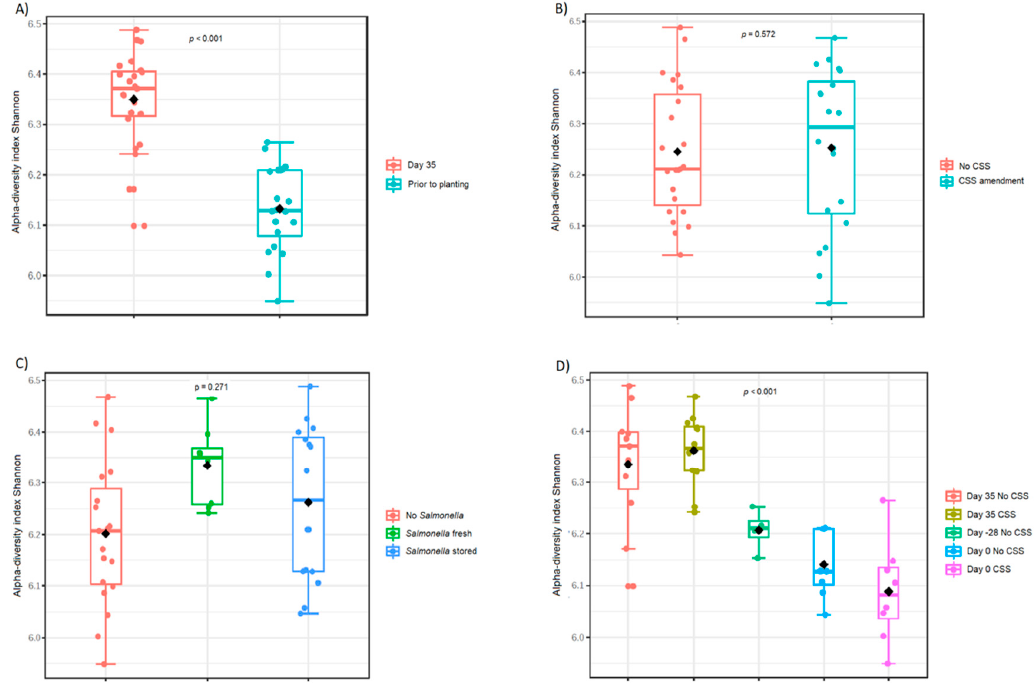
Figure 2. Diversity in the prokaryotic community represented using the Shannon index. The effects of B. rapa growth ( A ), amendment with sewage sludge compost ( B ), absence or presence of Salmonella ( C ), and time after planting ( D ) were calculated. The significance was tested using one-way ANOVA. The boxes represent the interquartile range between the first and the third quartile and the lines mark the median. In total, 43 samples were analyzed.